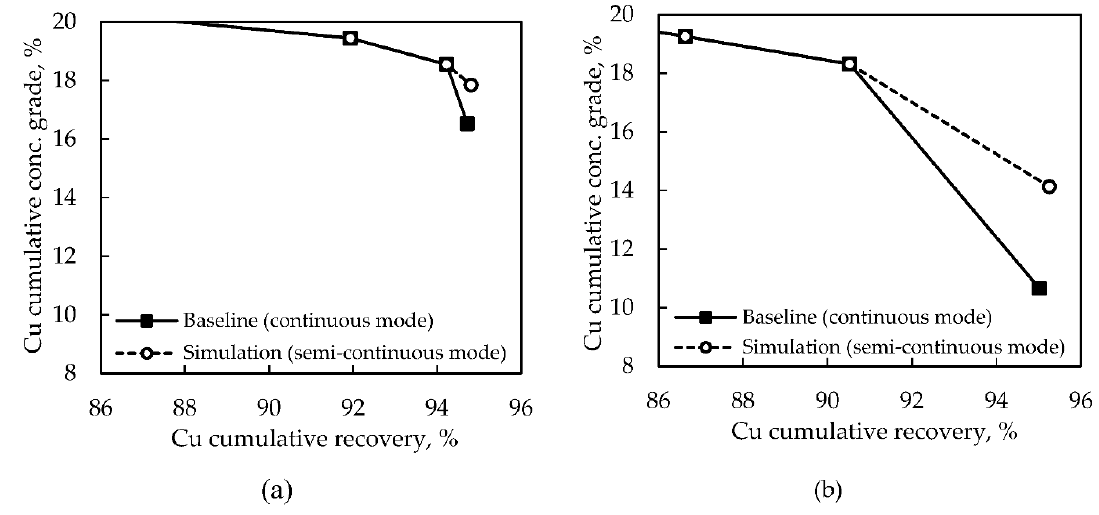
Figure 3. Comparison of continuous (experimental) and semi-continuous (simulated) grade–recovery profiles: ( a ) circuit A, and ( b ) circuit B.